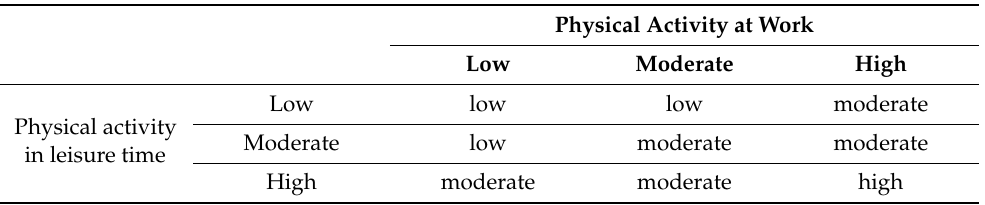
Table 3. Estimate the overall physical activity after combining data based on self-reported physical activity at work and physical activity in leisure